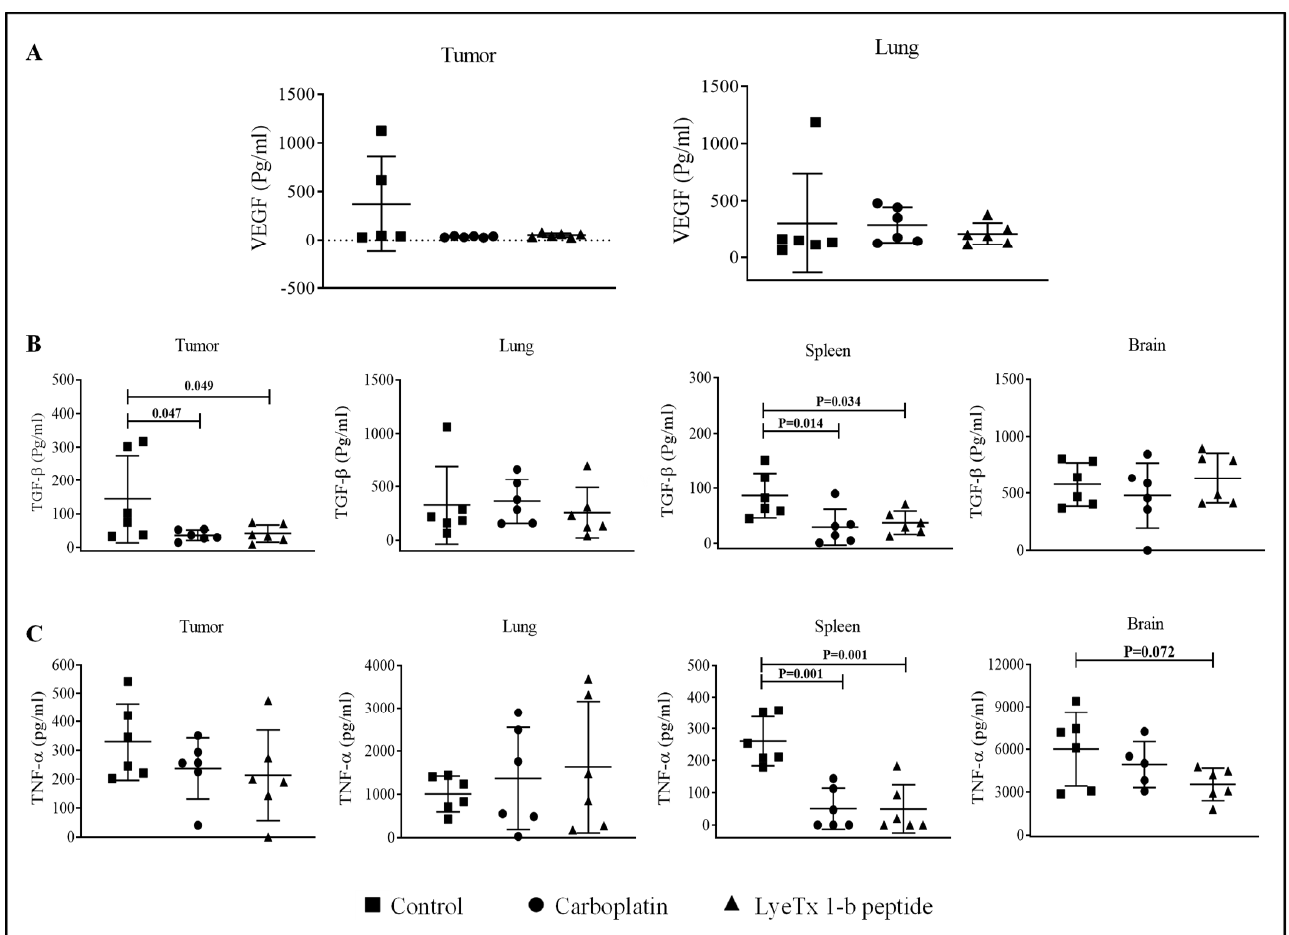
Figure 12. Cytokines levels in the tumor LyeTx I-b attenuated VEGF, TGF- β , and TNF- α levels in the tumor microenvi- ronment. Individual values of mice (pg/mL) are presented in a dot plot with an average of each group, n = 6. ( A ) Data correspond to VEGF differences found in primary tumor and lung. ( B , C ) TGF- β and TNF- α values in the primary tumor, brain, spleen, and lung. Statistical variation among groups was carried out in 6 animals of each group in duplicate using One-way ANOVA, p < 0.05.